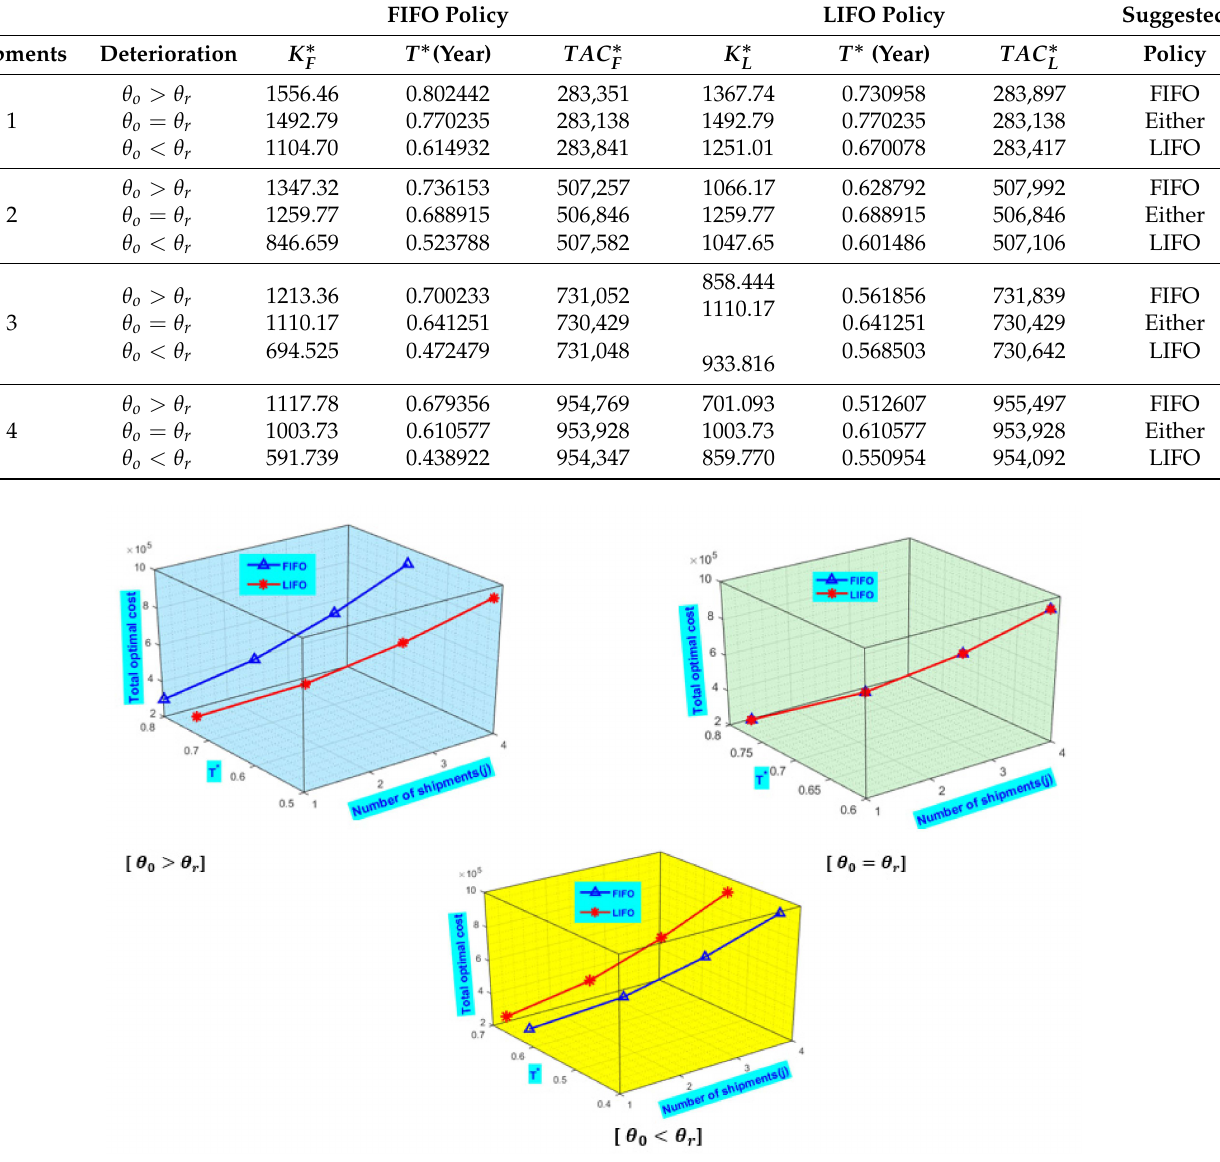
Figure 7. Graphical representation of total cost under a number of